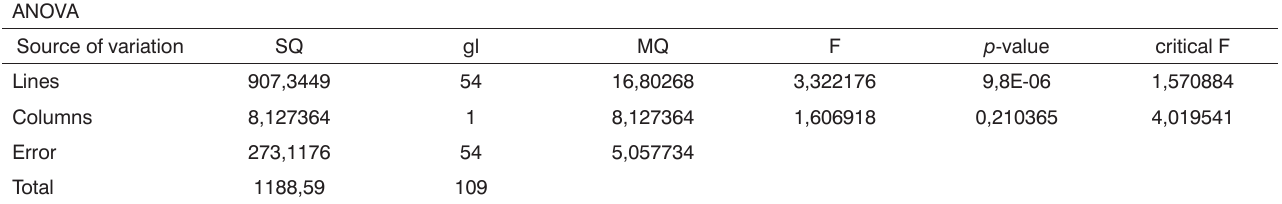
Table 3. Analysis of variance for the condition of absent noise, comparing the right and left ears